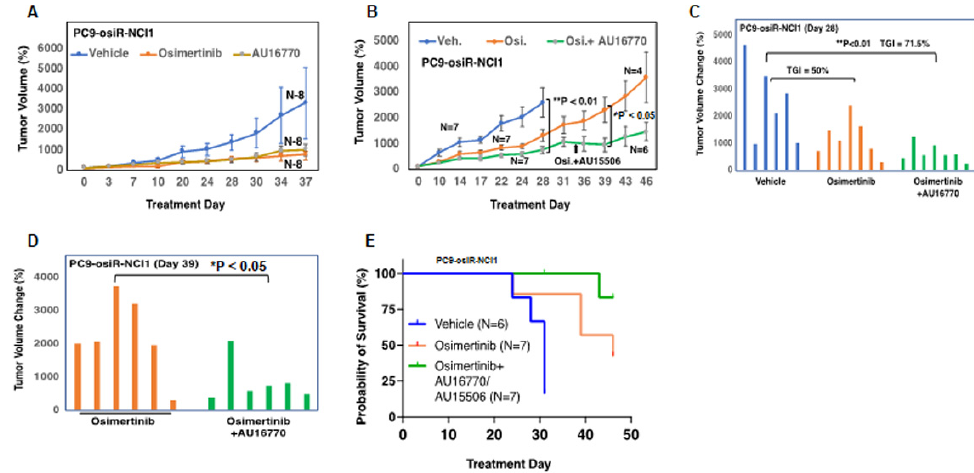
Figure 4. AU-16770 in combination with osimertinib inhibits tumor growth in PC9-osiR-NCI1 and H1975-osiR-NCI1 subcutaneous xenograft mouse models and increases overall survival. ( A ) Mice bearing PC9-osiR-NCI1-derived tumors were treated for 37 days with vehicle (N = 8), 5 mg/kg/day osimertinib (N = 8), or 5 mg/kg/day AU-16770 (N = 8). ( B ) Mice bearing PC9-osiR-NCI1-derived tumors were treated for 46 days with vehicle (N = 7), 5 mg/kg/day osimertinib (N = 7) or AU-16770- osimertinib (N = 7) (days 0–32), and AU-15506-osimertinib (days 33–46) in combination. Plot of daily percent tumor volume change shows AU-16770–osimertinib combination treatment reduces tumor size. ( C , D ) Bar plot of percent tumor volume changes in each mouse representing ( B ). Overall tumor burden is significantly reduced in mice treated with AU-16770–osimertinib and AU-15506–osimertinib combination treatment compared to vehicle ( C ) or osimertinib ( D ) Tumor growth inhibition (TGI) is calculated by [1 − mean tumor volume of treatment group/tumor volume of vehicle control group] × 100. ( E ) Kaplan–Meier survival curves of mice bearing PC9-osiR-NCI1-derived tumors treated with vehicle (N = 6), osimertinib (N = 7), or AU-16770–osimertinib and AU-15506–osimertinib (N = 7) combination.